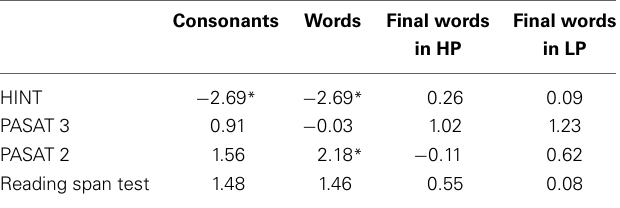
Table 4 | Fisher’s Z scores to compare correlation coefficients between silence and